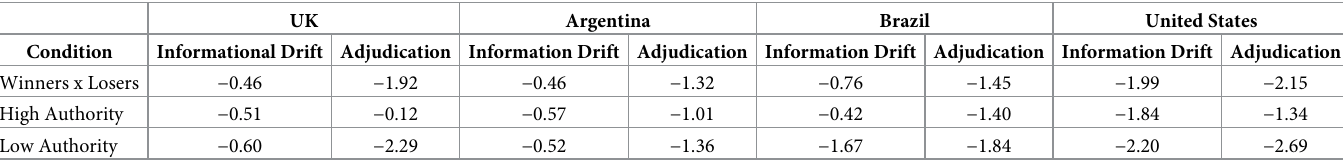
Table 1. Adjudication in four cases: Information drift and adjudication effect.